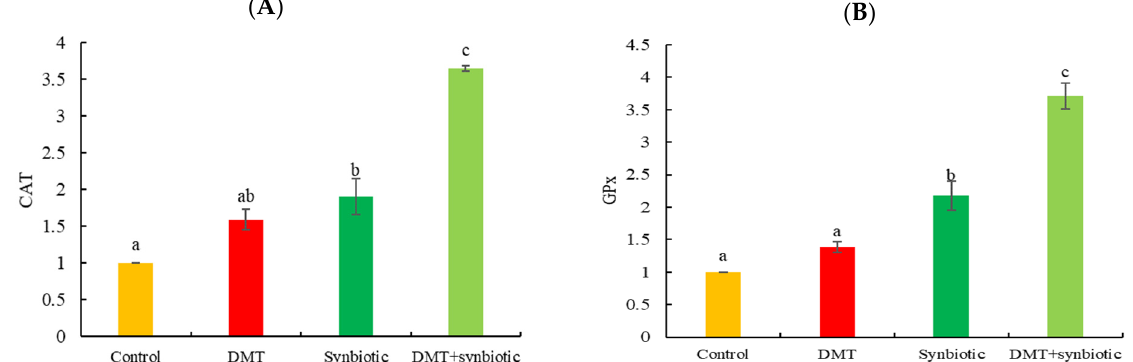
Figure 6. Transcription of antioxidative genes: ( A ) catalase (CAT) and ( B ) glutathione peroxidase (GPx) in Nile tilapia treated with deltamethrin (DMT) with synbiotic feeding. Bars represent mean ± SD (n = 3), and different letters show significant differences ( p < 0.05).